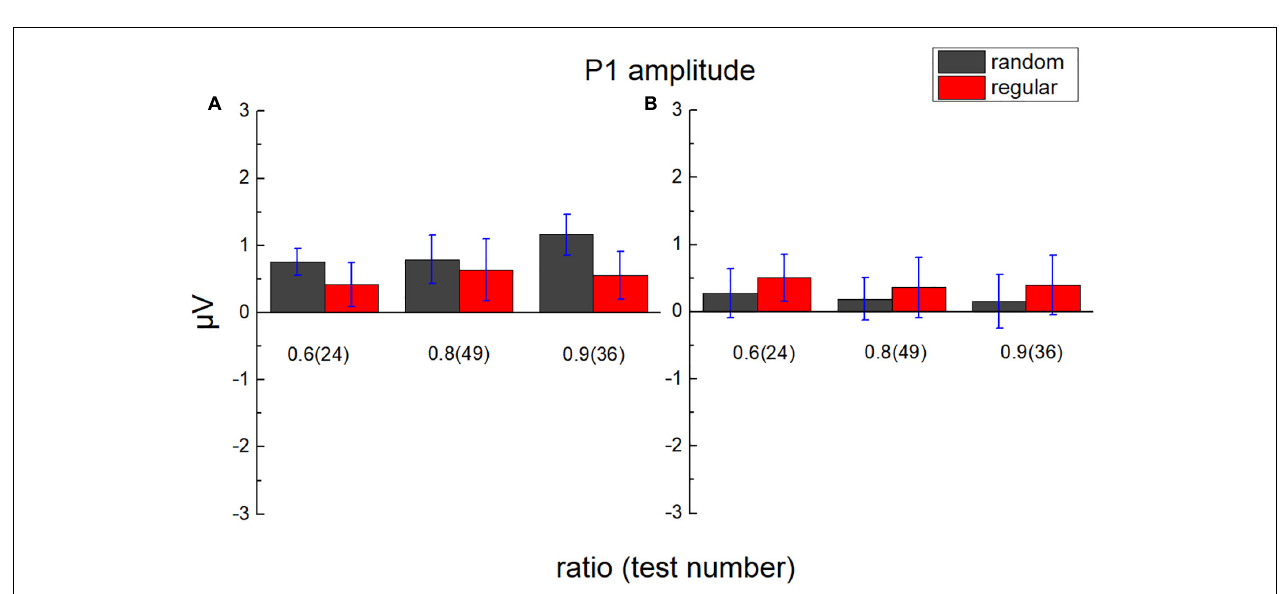
FIGURE 6 | Average P1 amplitude in the parietal lobe and the occipital lobe. (A) The average amplitude of the ERP of participants in the parietal lobe from 80 to 120 ms after test presentation (P1) is demonstrated according to different test ratios (0.6, 0.8, and 0.9). (B) The average amplitude of ERP in the occipital lobe from 65 to 90 ms after the test. Black bars stand for the randomly distributed patterns, and red ones stand for the regularly distributed patterns. Error bars denote 1 SE of the mean.